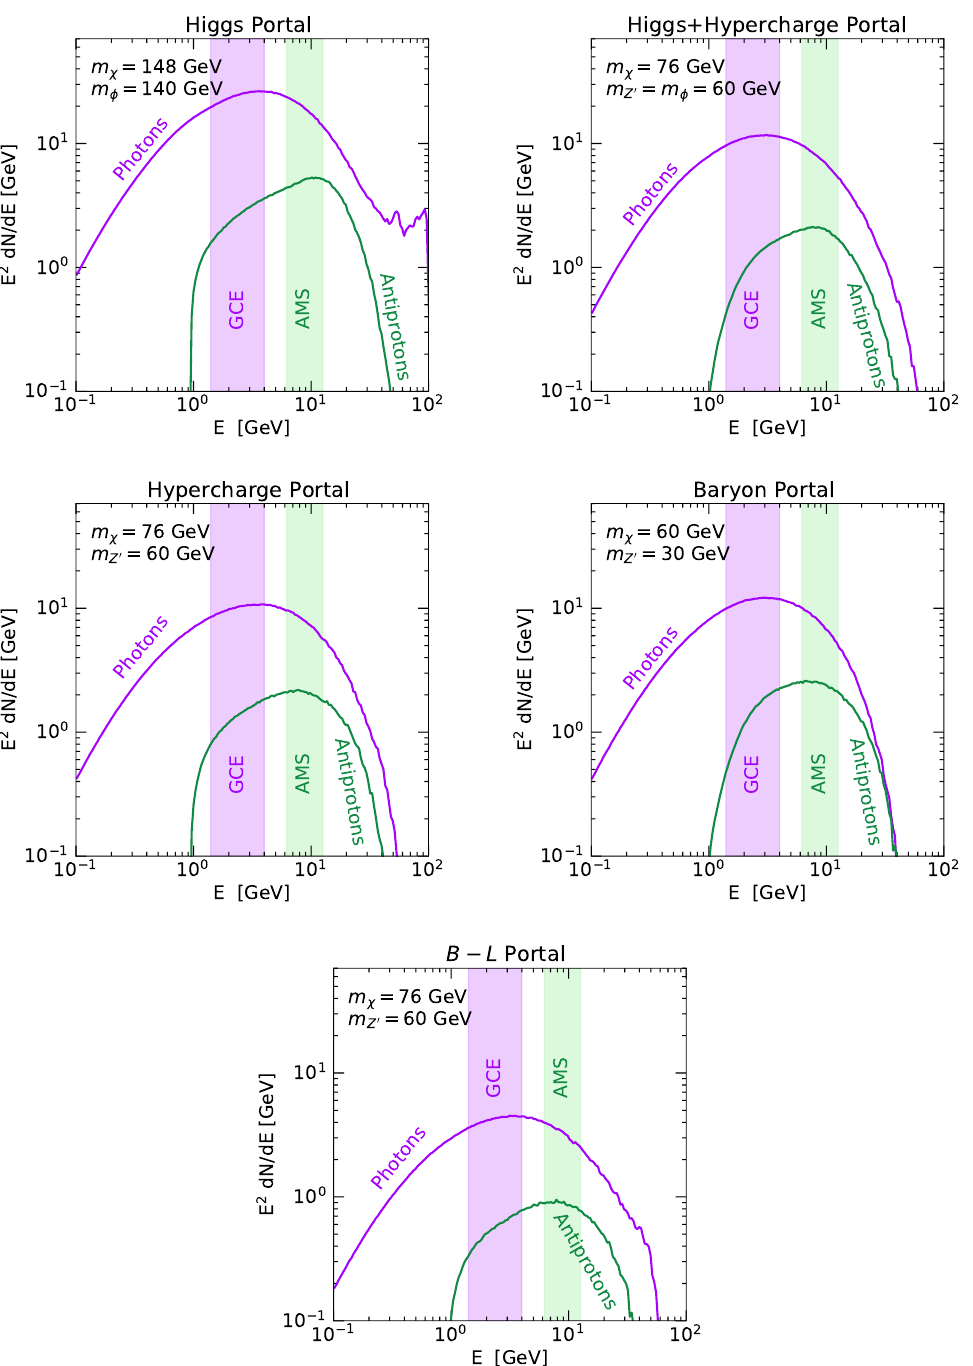
Figure 4 . Gamma-ray and antiproton spectra for a selection of representative hidden sector dark matter models, each of which can simultaneously accommodate both the Galactic Center gamma- ray and cosmic-ray antiproton excesses. The target regions that the spectra are required to peak in are shown as the purple and green shaded regions, as described in the text.